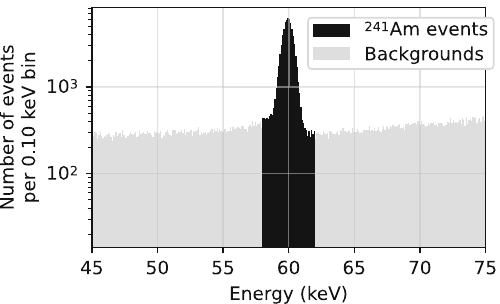
Fig. 8 Amplitudedistribution(convertedtoenergy)ofthe 241 Amdata, as calculated from the trapezoidal filter. Events in the dark region are within ± 2keV of the peak and taken to be signal events from the 241 Am source,whileeventsinthelightregionaretakentobebackgrounds.Note that the y-axis is logarithmic